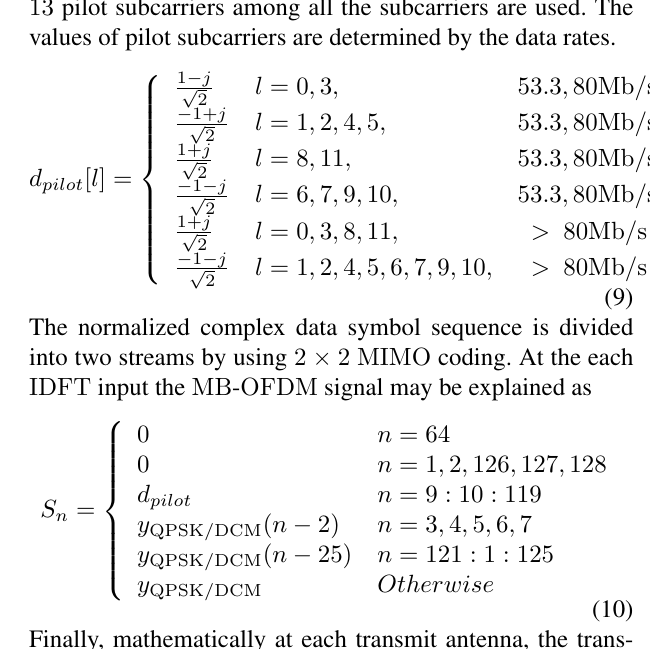
13 pilot subcarriers among all the subcarriers are used.